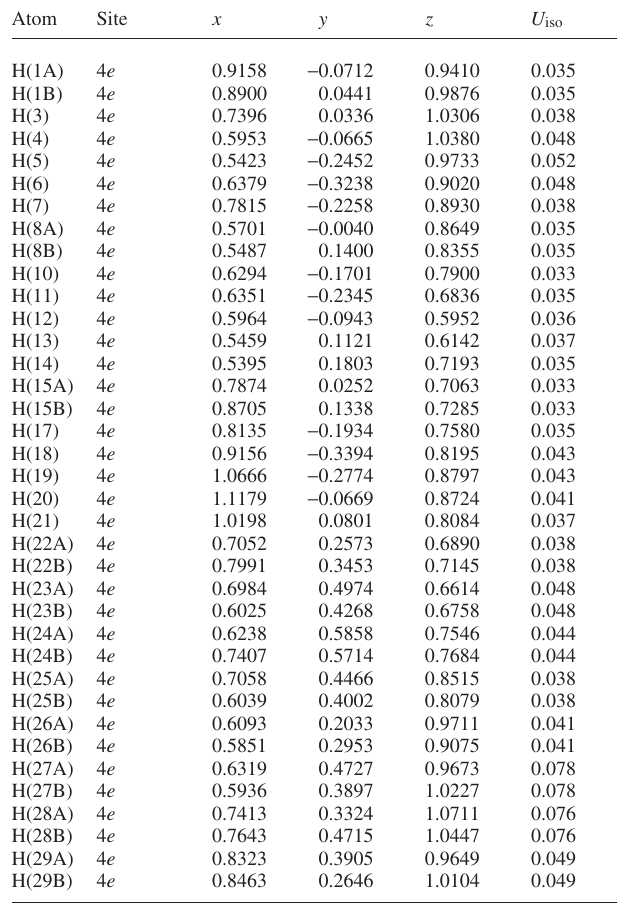
Table 2. Atomic coordinates and displacement parameters (in Å 2 )